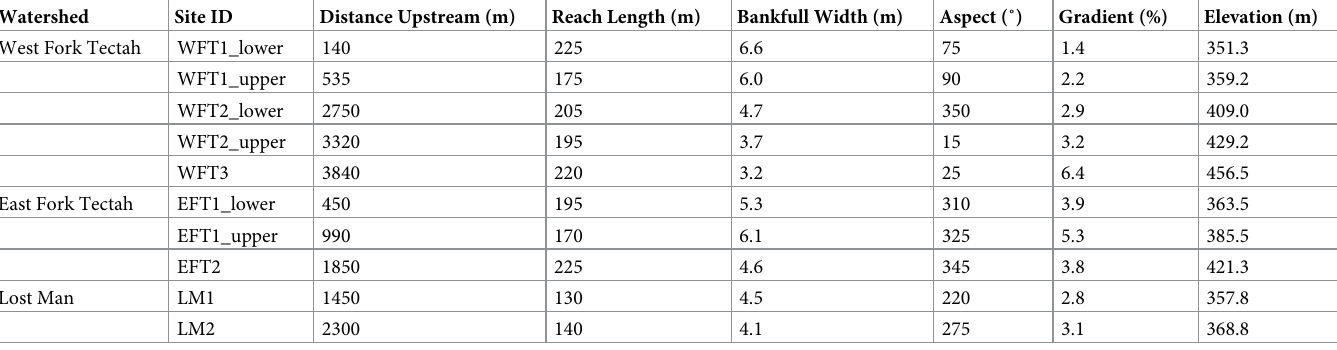
Table 1. Study site